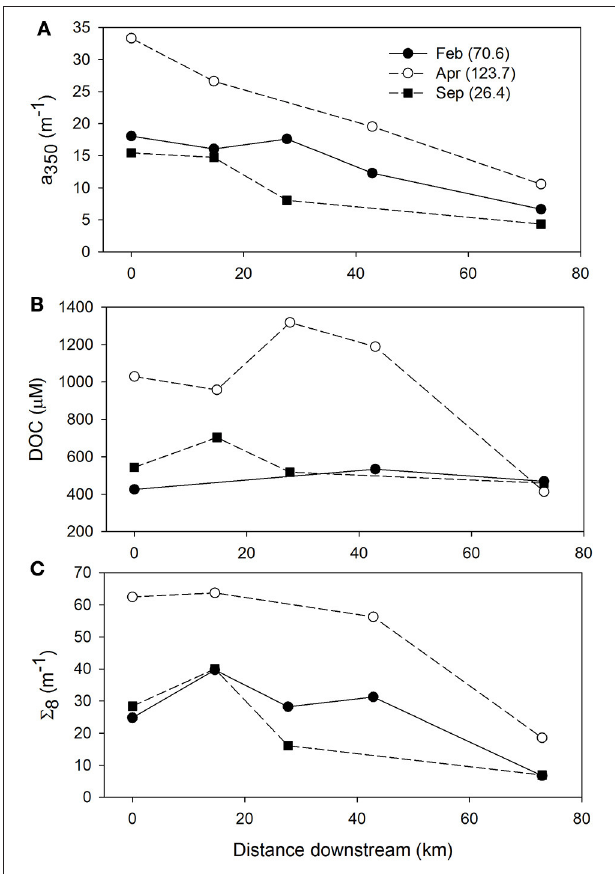
FIGURE 9 | Within system variability of (A) CDOM absorption at a 350 , (B) DOC concentration, and (C) lignin concentration for the meso-eutrophic Neuse River Estuary. Values in parentheses for each month are the mean discharge at Ft. Barnwell, NC (USGS Station 02091814) for the 7 days preceding the date of